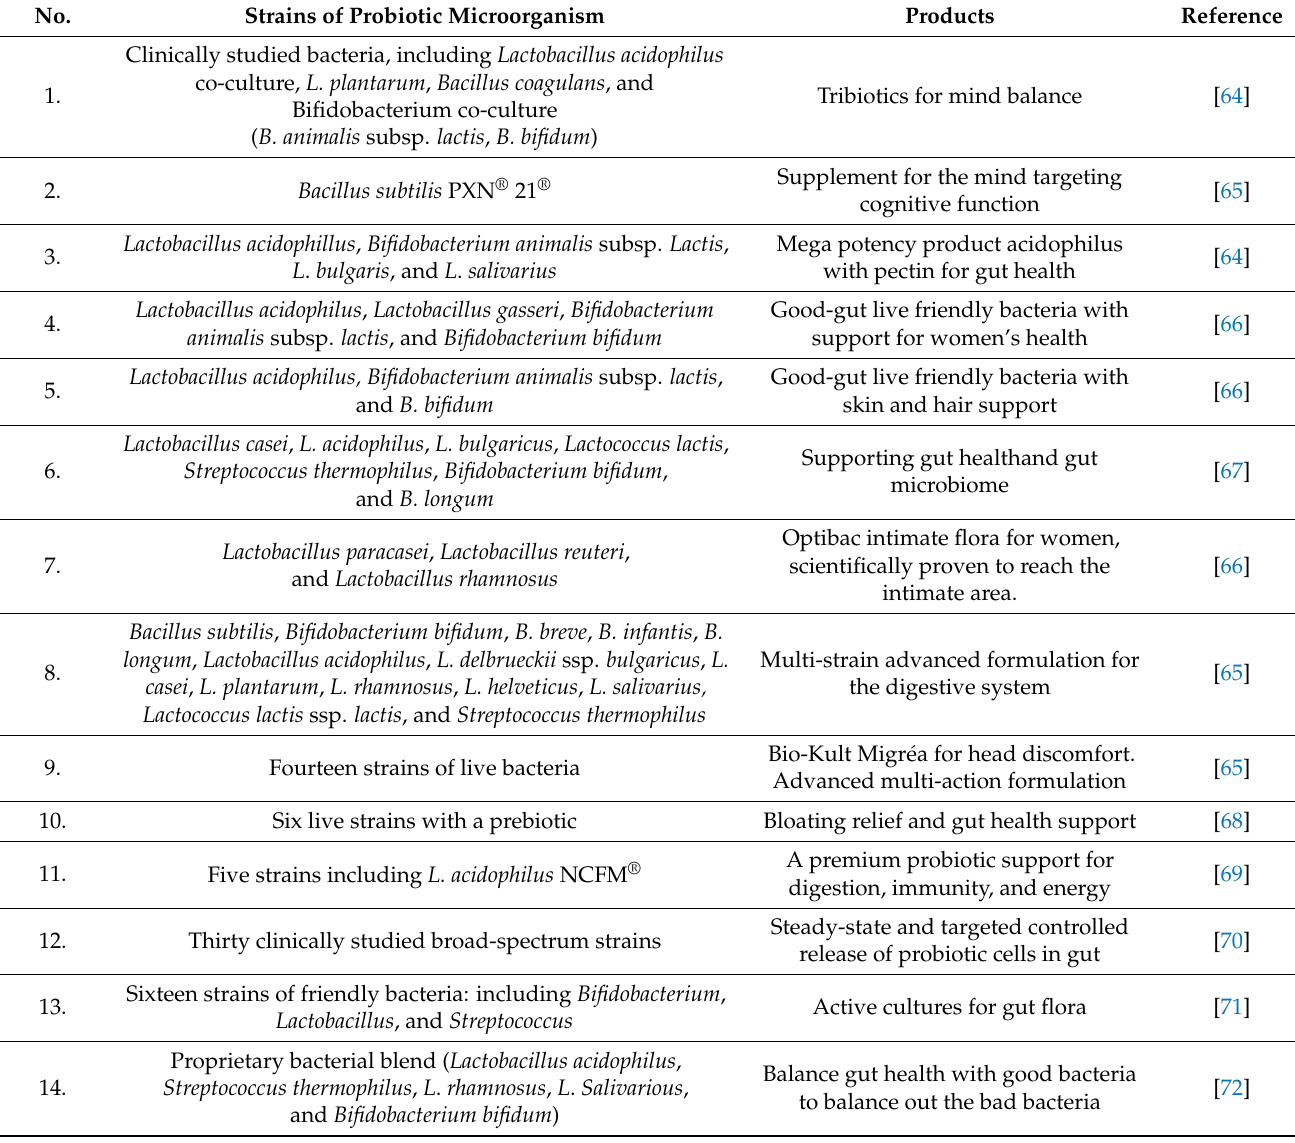
Table 2. A list of strains used in form of encapsulated freeze-dried cells for the formulation of supplement products [Information from online sources assessed during May–July